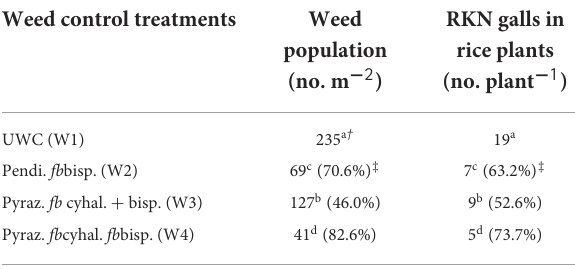
TABLE 8 Reduction in weed population (no. m − 2 ) and root-knot nematode (RKN) galls in rice plants (no. plant − 1 ) across the weed control/herbicides treatments at 60 DAS/DAT (Pooled mean of 2